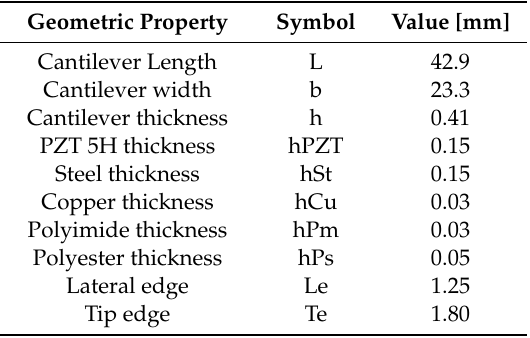
Table A3. Dimensional properties of the